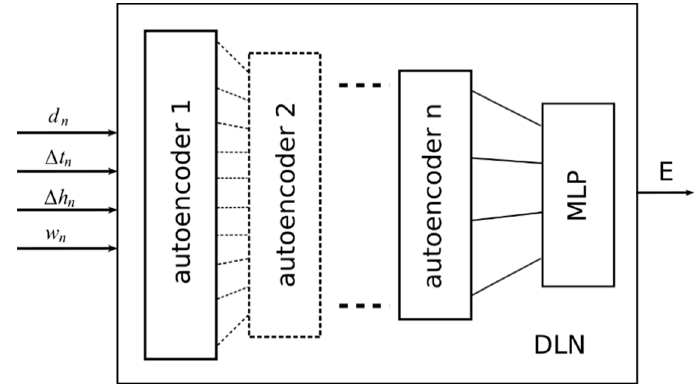
Figure 6. Energy consumption estimation model using a deep learning network.